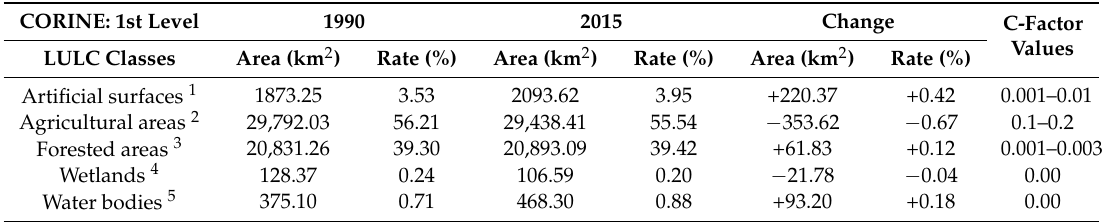
Table 1. The list of LULC classes according to CORINE Land Cover